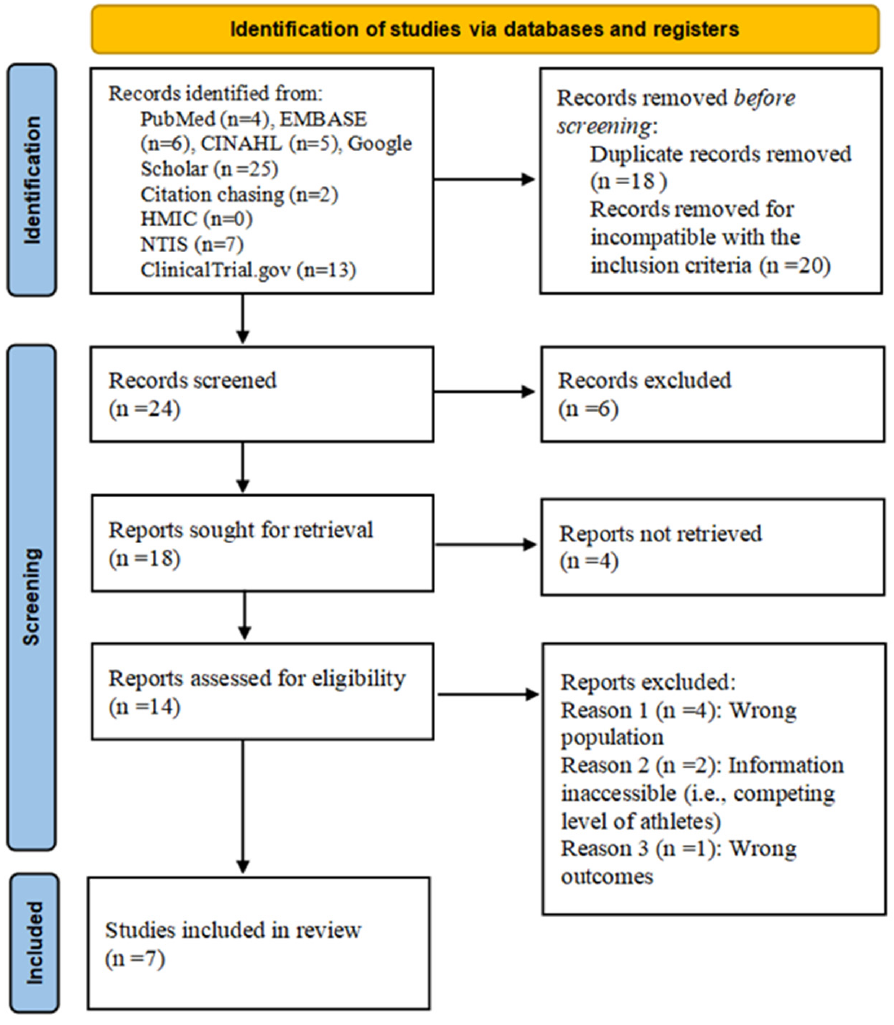
Figure 1. PRISMA flow diagram showing the study selection process [36]. PRISMA, Preferred Reporting Items for Systematic Review and Meta-Analysis.